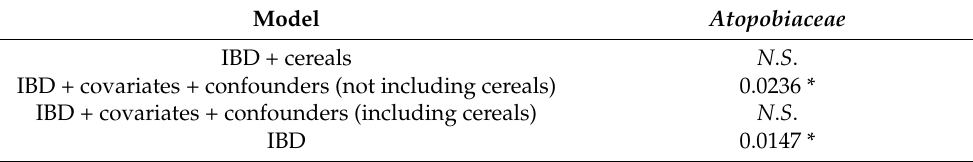
Figure 2. Venn diagram indicating the bacterial families identified using the IBD and IBDCC models. Table 2. Analysis of the variables’ (covariates and confounders) impact on bacterial families that were differently identified using the IBD and IBDCC models. The significance of the Atopobiaceae family was related to the presence of the “cereals” variable. The symbol “*” indicates a p -value ≤